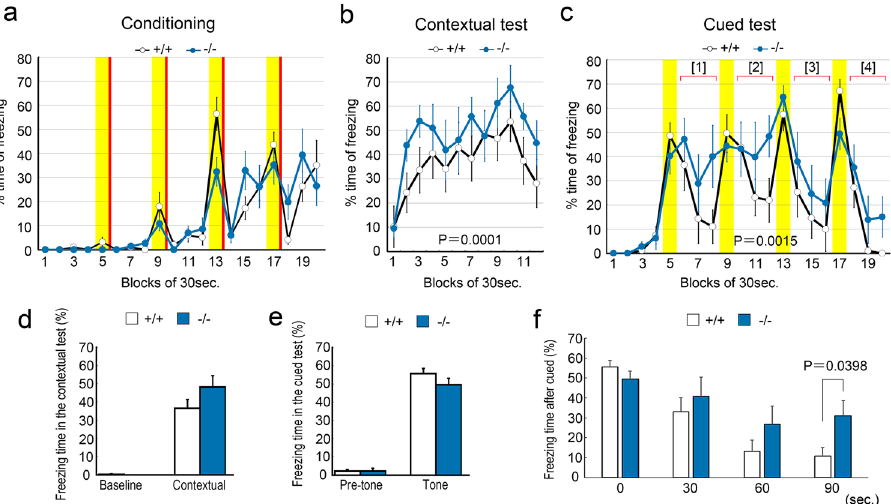
Figure 8. Reduced fear extinction of the Pcdh9 KO mice. ( a – c ) Time course of freezing during conditioning, contextual, and cued tests in the conventional fear-conditioned memory test. The yellow shadows indicate the periods with tone stimulations whereas the red bars indicate the points of electric shocks. In both contextual and cued tests, a fear memory was established. In the recovery phases (Period [1]–[4]), freezing time of the Pcdh9 KO mice was significantly longer than that of the wt mice (2-way ANOVA). ( d , e ) In both contextual and cued tests, the total freezing time of the Pcdh9 KO mice was not different from that of the wt mice. However, during the time course, the freezing time of the Pcdh9 KO mice was longer than that of the wt mice in the contextual test with 2-way ANOVA analysis ( b ). ( f ) Comparison of the freezing time during the recovery phase of the cued test. The sum of the freezing times of each bin during four recovery phases (Period [1]–[4]) in the cued test is shown. The degree of freezing of the Pcdh9 KO mice was significantly larger than that of the wt mice during the recovery from